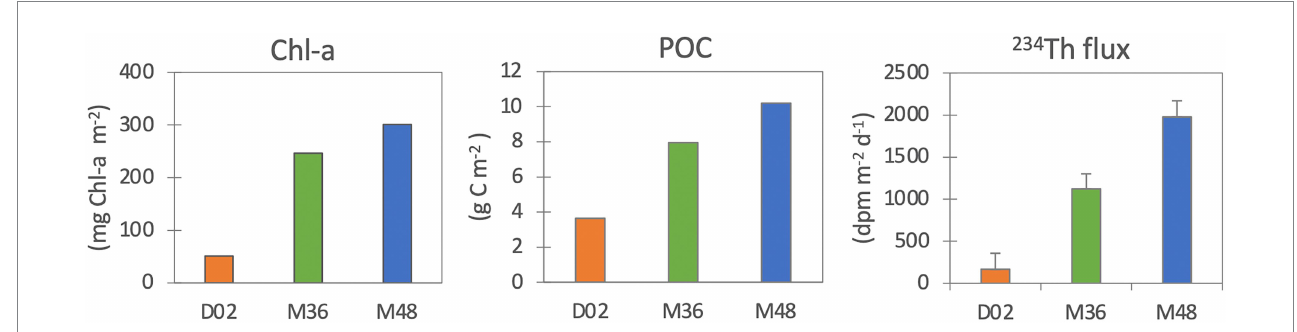
FIGURE 1 Chlorophyll-a (mg Chl-a m − 2 ), particulate organic carbon (mg C m − 2 ) stocks in the upper water column (upper 20 m) and 234 Th export fluxes (dpm m − 2 d − 1